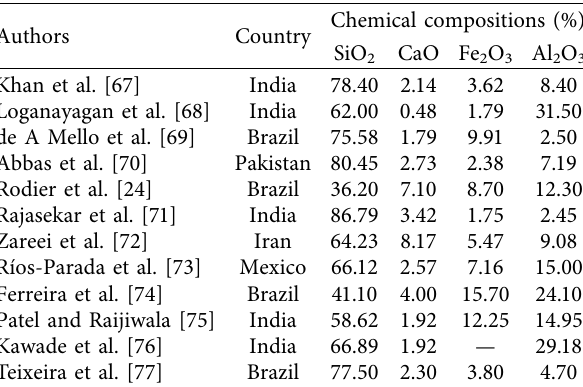
Table 6: Mineral oxides of SCBA conducted by various